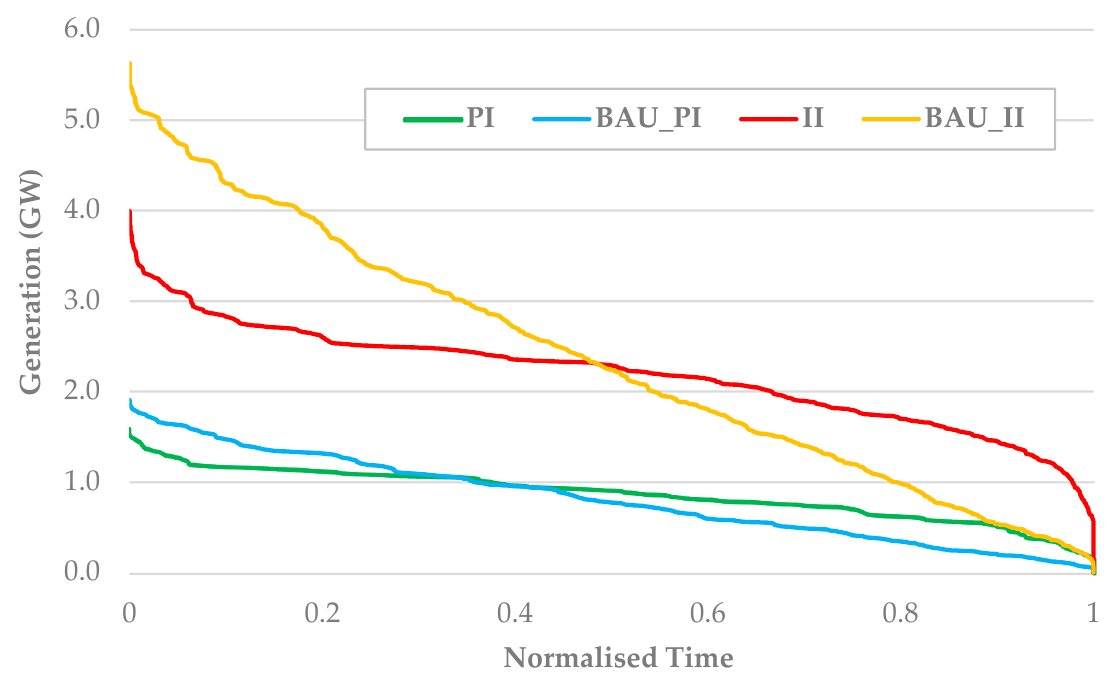
Figure 9. Load duration curve for renewable energy generated by scenario island or offshore wind capacity. A flatter, horizontal curve indicates more consistent generation. Table 5. Description of generation (GW) from fossil fuel sources (CCGT, coal and OCGT), showing how reduced variability of renewable corresponds to an equivalent but less pronounced reduction in variability for dispatchable generation.